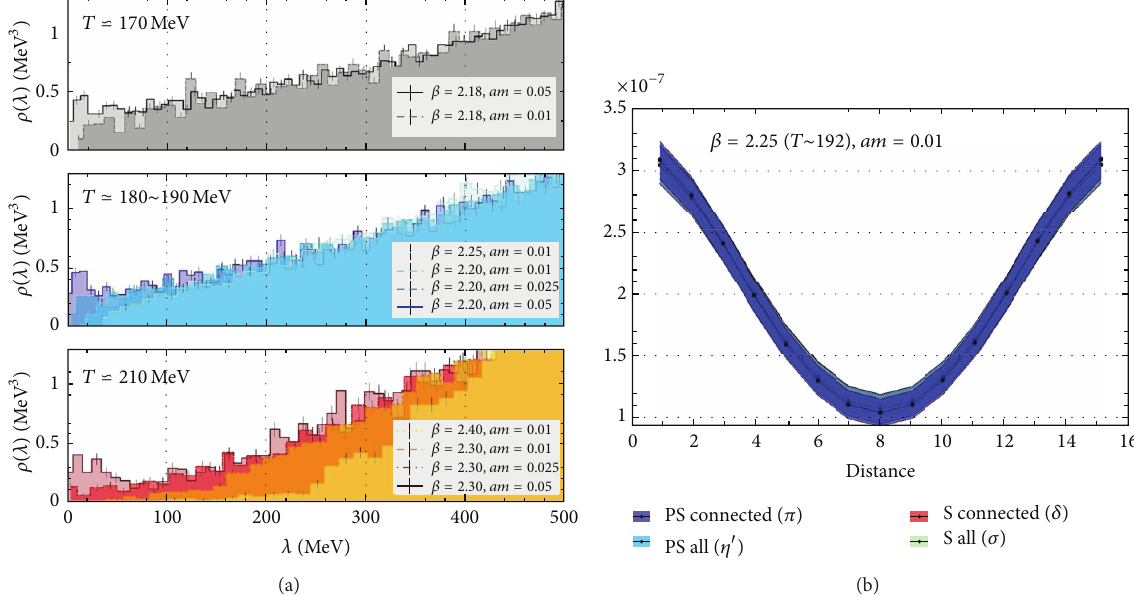
Figure 12: In (a), the quark mass dependence of eigenvalue distribution for the overlap quarks is compared at different temperatures, from [75, 76]. In (b), the degeneracy of the scalar and pseudoscalar mesons for overlap quarks are shown at a temperature of 192MeV which is slightly higher than the corresponding pseudocritical temperature, from [75,